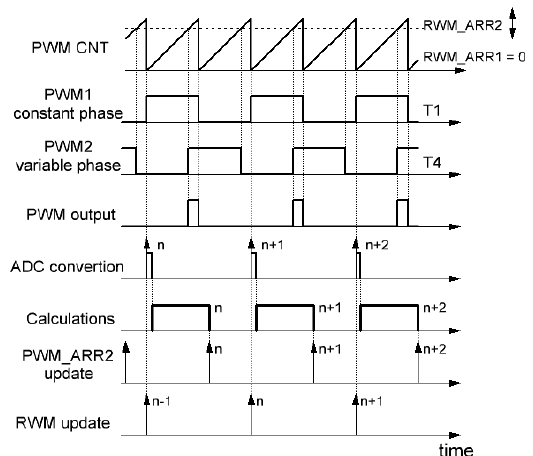
Figure 5. Phase shift pulse-width modulation (PWM) timing diagram. Complementary signals and dead times are not shown.